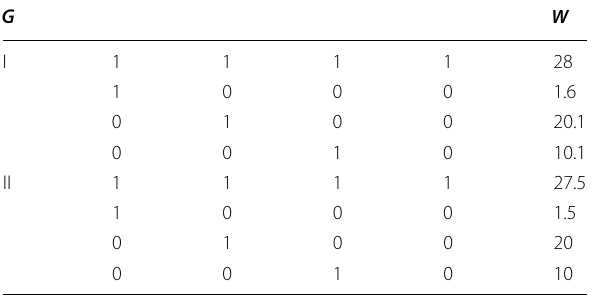
Table 6 Inequality constraint data for the third example G